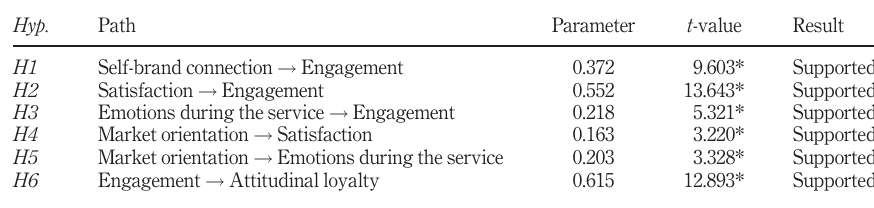
Table VI. Summary results of the structural model